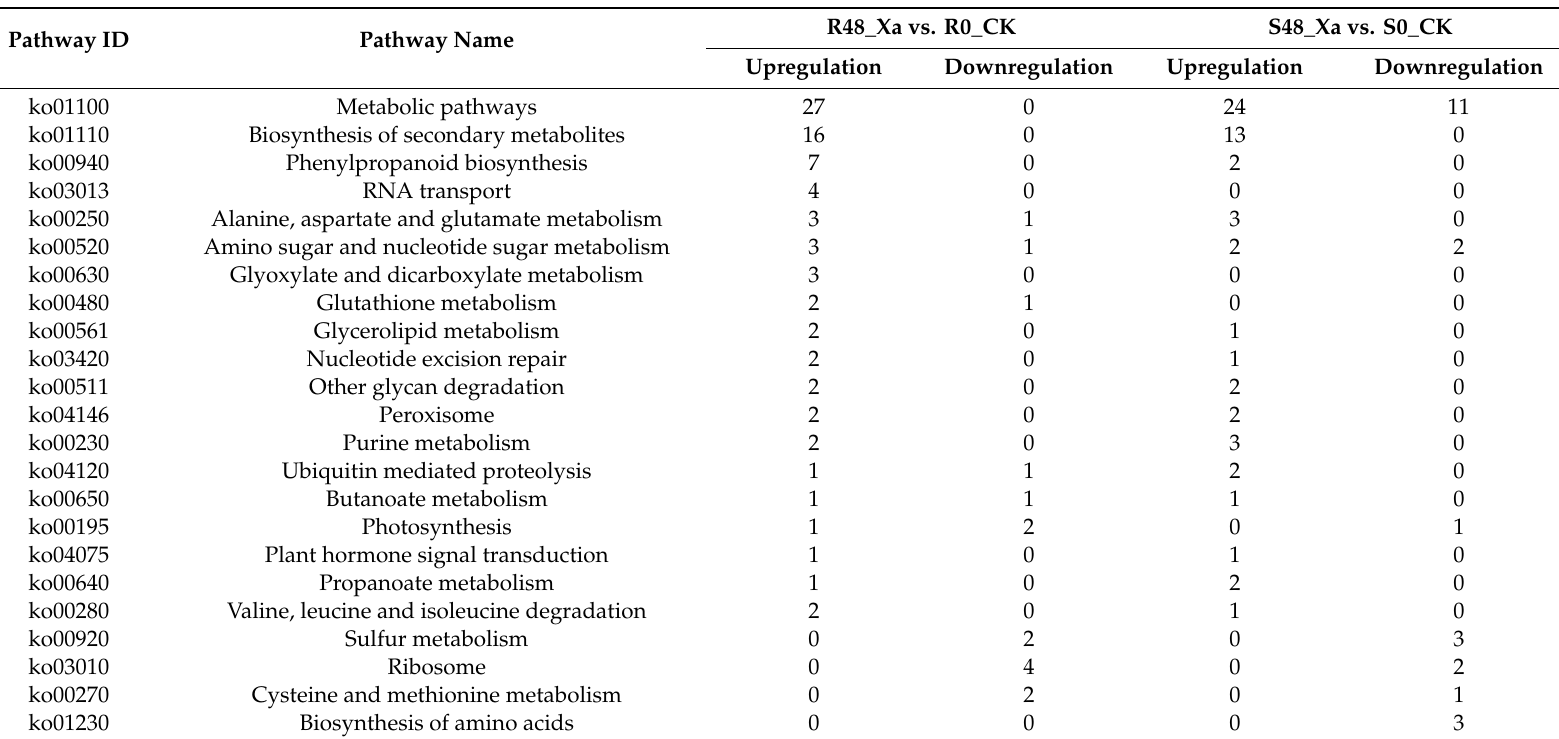
Table 2. Number of di ff erentially expressed proteins (DEPs) in major KEGG pathways identified in two sugarcane cultivars LCP 85–384 (resistant to leaf scald) and ROC20 (susceptible to leaf scald) after inoculation with Xanthomonas albilineans a